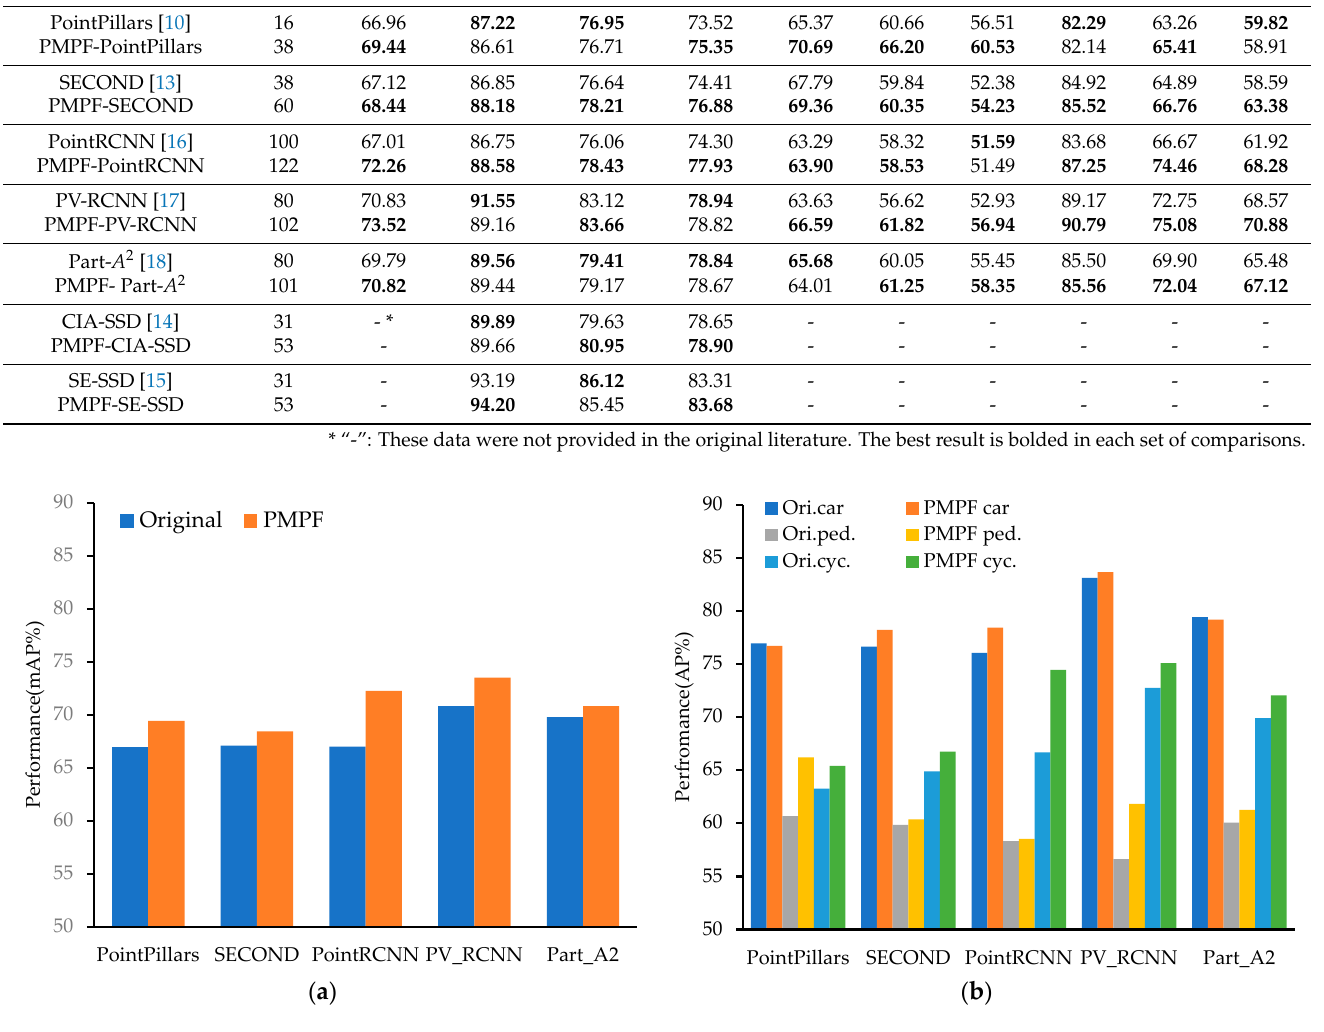
Figure 4. PMPF is a plug-and-play fusion method that can be used in any 3D detector with an autoencoder. ( a ) Comparison of the mean average accuracy of all classes on the KITTI validation set on moderate difficulty for seven LiDAR detectors using the PMPF method and their original detectors. ( b ) Comparison of all-class accuracy on the KITTI validation set for moderate difficulty.